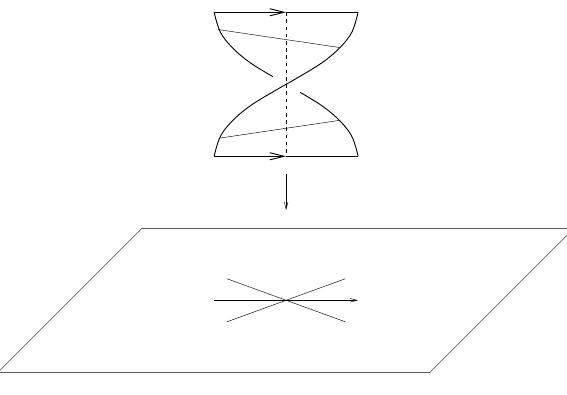
Figure 7: Blowing up a point in R 2